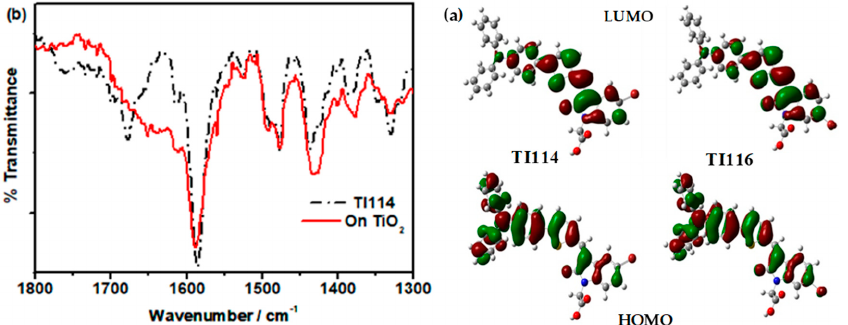
Figure 3. ( a ) Frontier molecular orbital profiles of TI114 and TI116 at the B3LYP/6-31g (d,p) level. ( b ) FTIR spectra of the TI114 dye powder and dye adsorbed on film.